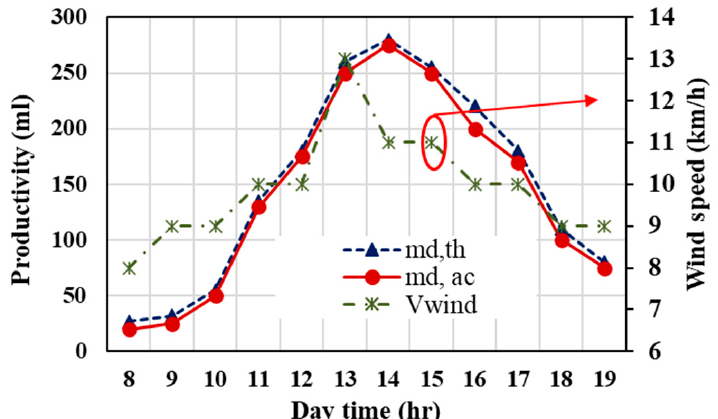
Figure 8. Productivity variation during the day (reading taken 23 June 2020) and the circle and arrow in the figure refers to the secondary axis for wind speed also the abbreviations in the figure are as follows: m d = theoretical productivity, m ac = actual productivity, and V wind = Wind velocity.